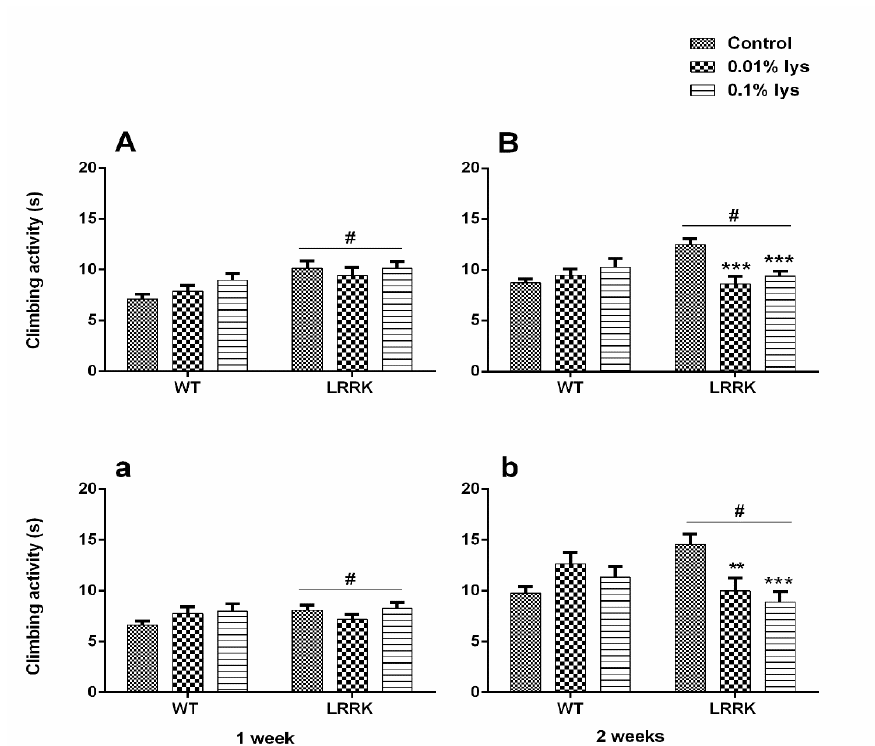
Figure 4. Effects of mDLE and fDLE treatments on climbing activity of mutant WT and LRRK flies, with mDLE ( A , B ) and fDLE ( a , b ) in their diet at 7 ( A , a ) and 14 ( B , b ) days of treatment, respectively. Bars represent mean ± SEM of 20–40 fly groups in triplicate. # = p < 0.05 WTs versus LRRK in ( A ), ( a ) and ( b ) groups; ** = p < 0.01 LRRK versus WTs control and WT mDLE (0.01%) and *** = p < 0.0001 LRRK versus LRRK (0.01%) and mDLE (0.1%), respectively. ** = p < 0.01 LRRK versus LRRK (0.01%) and *** = p < 0.0001 LRRK versus LRRK fDLE (0.1%, Tukey ’s test).